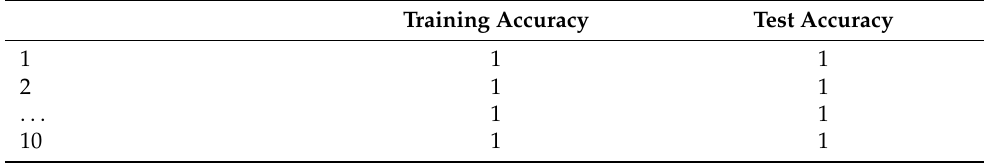
Table 8. Random Forest results.